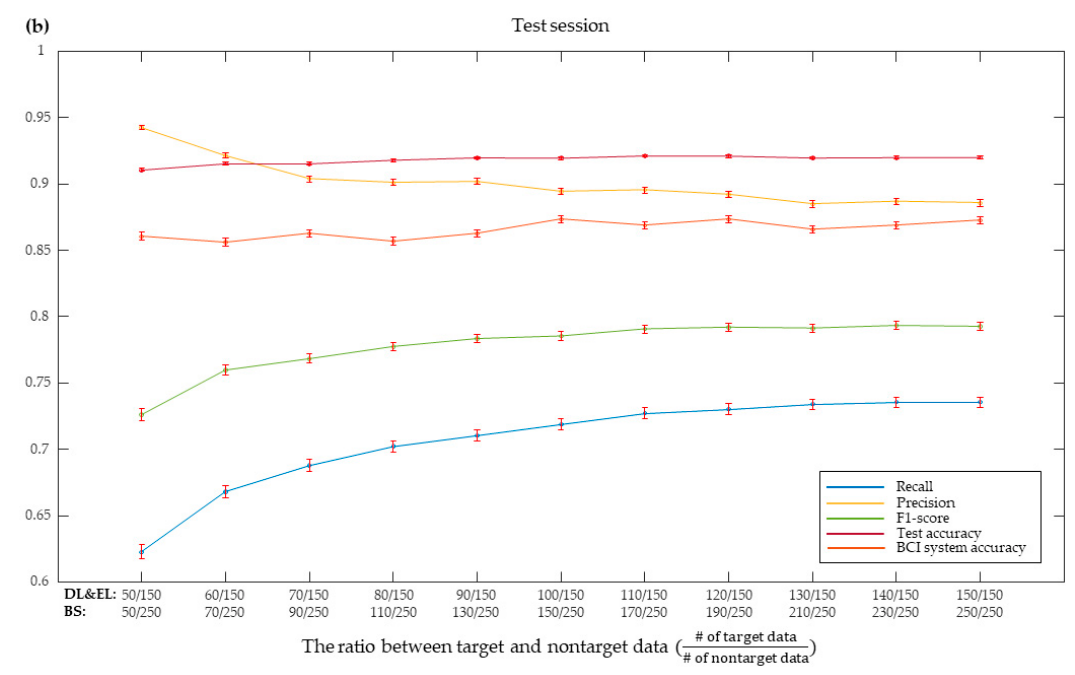
Figure 6. Performance of raw model with borderline-SMOTE according to target and nontarget data ratio during training ( a ) and testing ( b ), respectively. DL: Door lock, EL: Electric light, BS: Bluetooth speaker. Training accuracy is the result of binary classification that classifies target and nontarget.